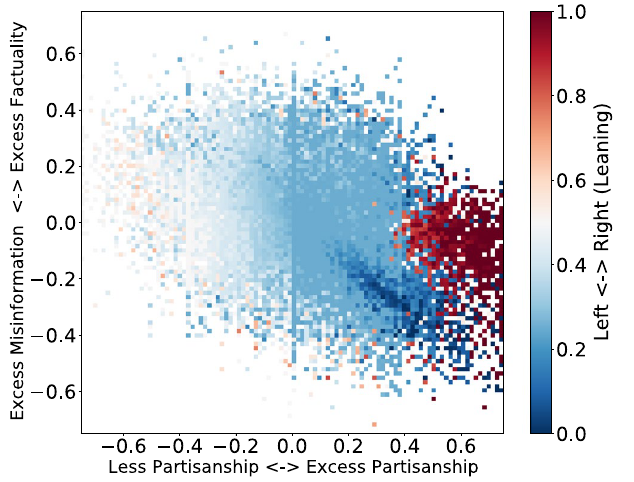
Figure 4. Excess factuality (cid:31) f vs excess partisanship (cid:31) p